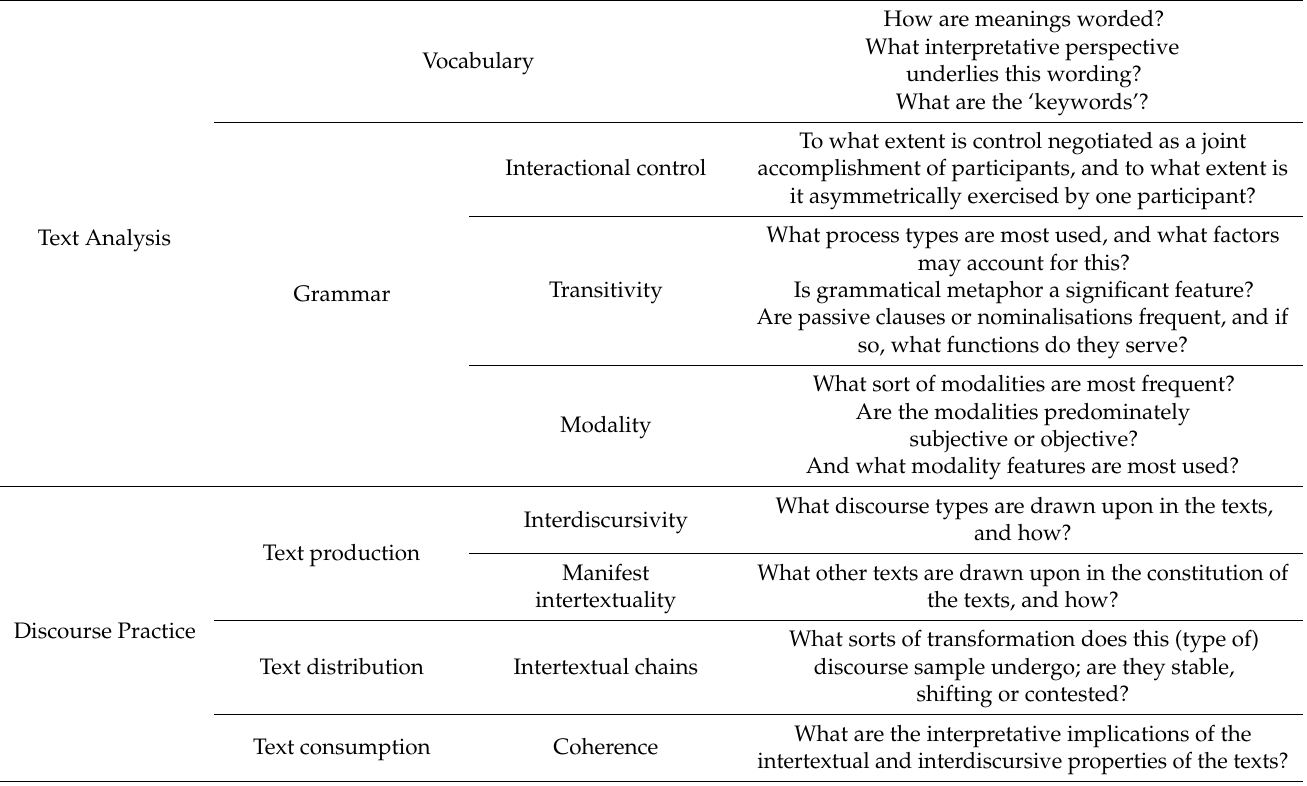
Table 1. The Fairclough inspired main analytical question